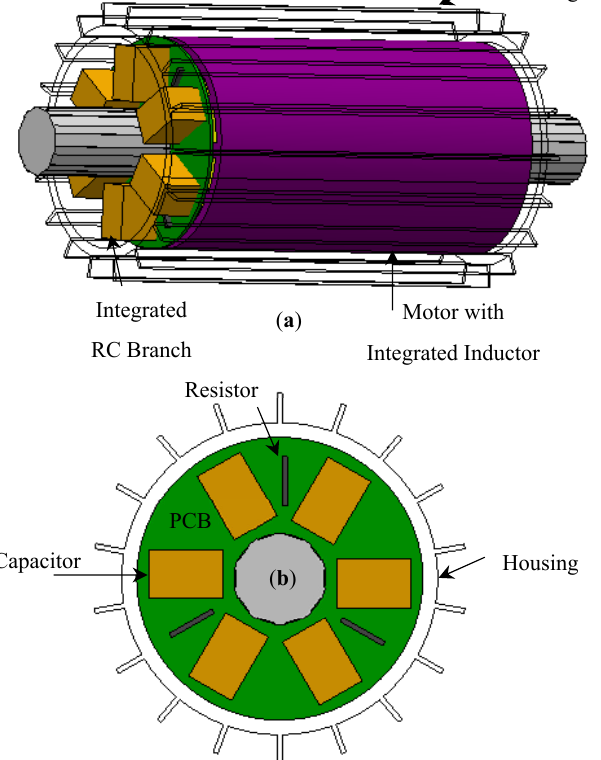
Figure 21. Integration of RC Branch ( a ) Axial view of the motor and PCB ( b ) Radial view of the damping resistors and filter capacitors mounted on the PCB.